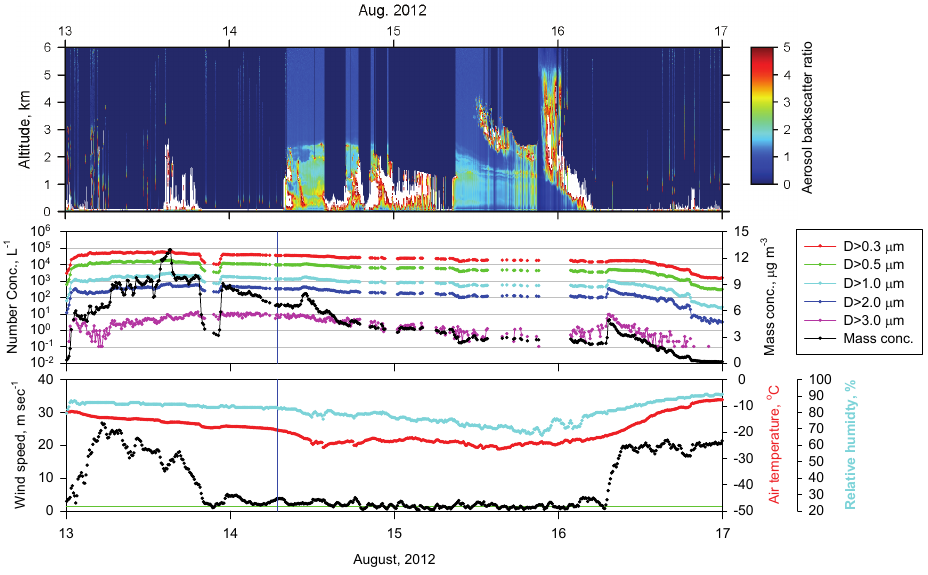
Fig. 1. Short-term variation of aerosol backscatter ratio, aerosol number concentration, mass concentration, wind speed, air temperature, and relative humidity near the surface on 13–16 August 2012 at Syowa Station,